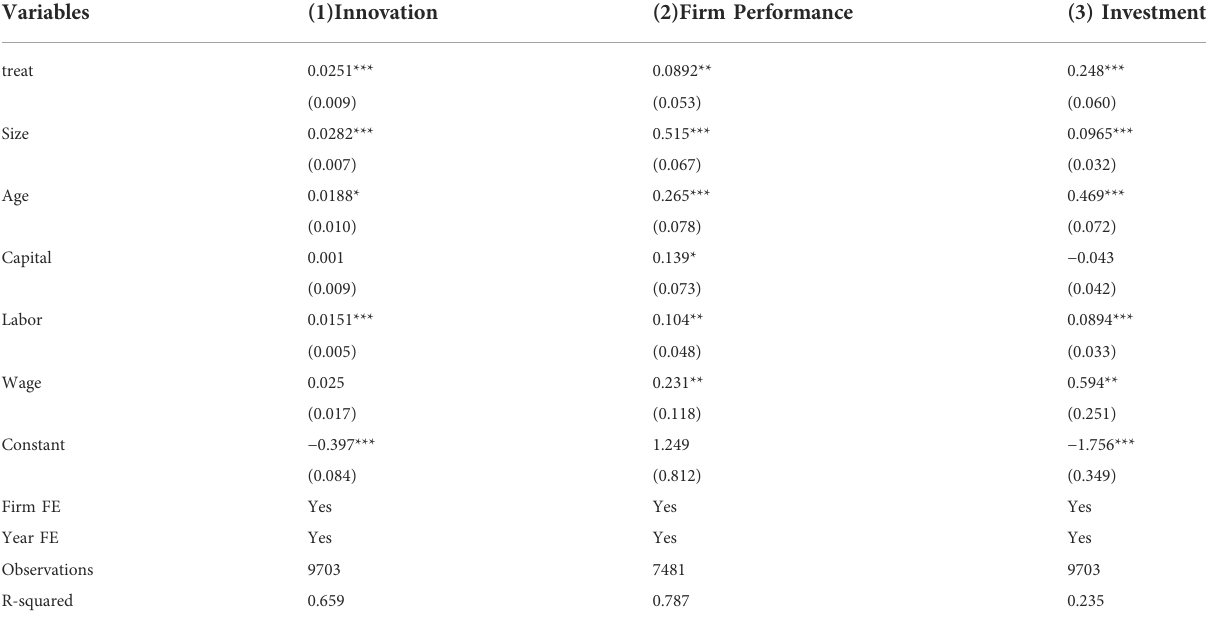
TABLE 7 The mechanism